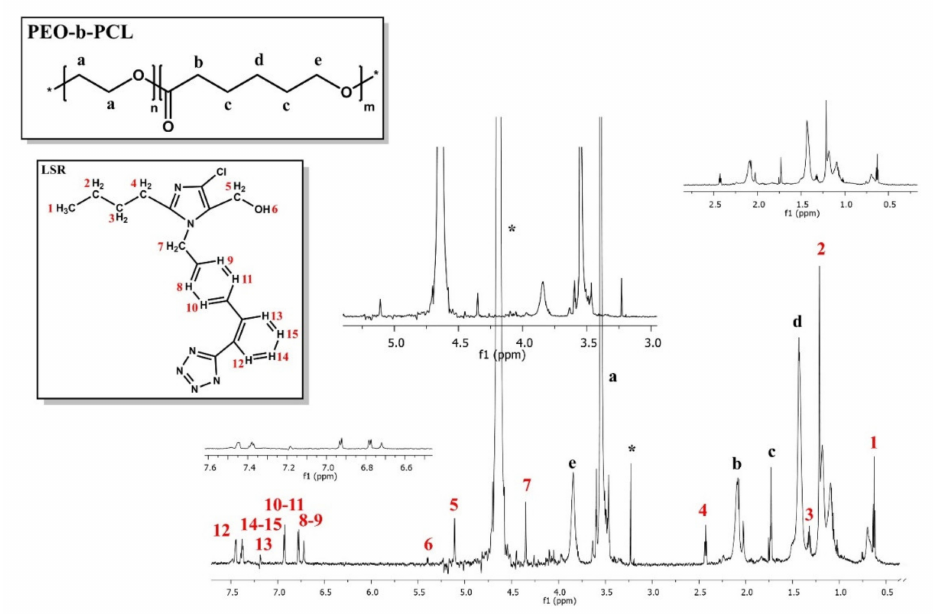
Figure 7. 1 H-NMR spectrum for the PEO-b-PCL + 50% LSR nanocarriers in D 2 O solutions, where the black letters denote the protons of the copolymer structure (a–e), the red letters point to the LSR peaks and the asterisk refers to the solvent D 2